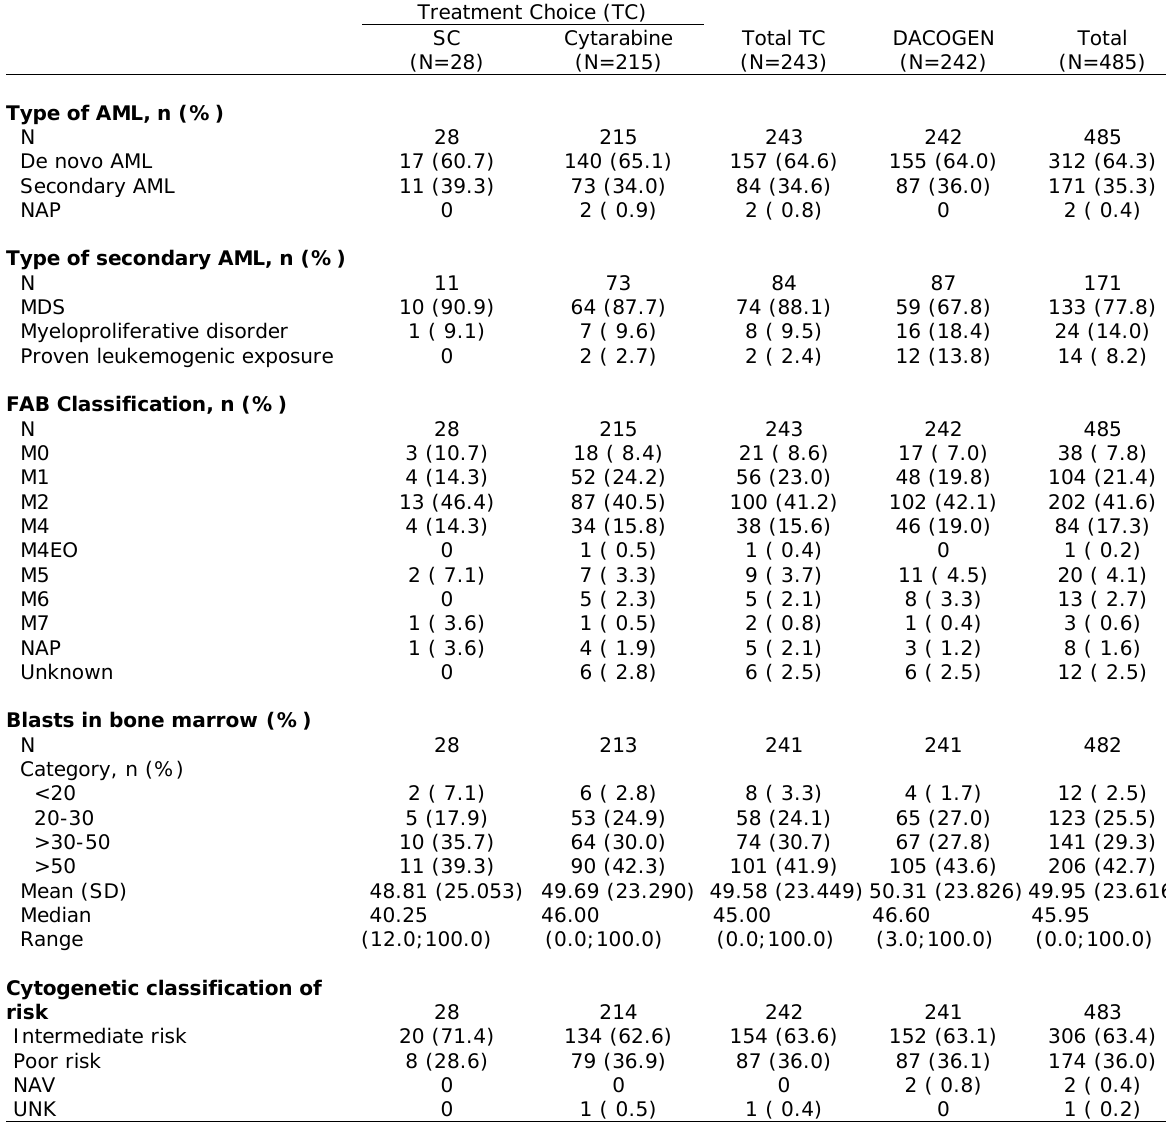
Table 17: Baseline Disease Characteristics (Study DACO-016) (Intent-to-Treat Analysis